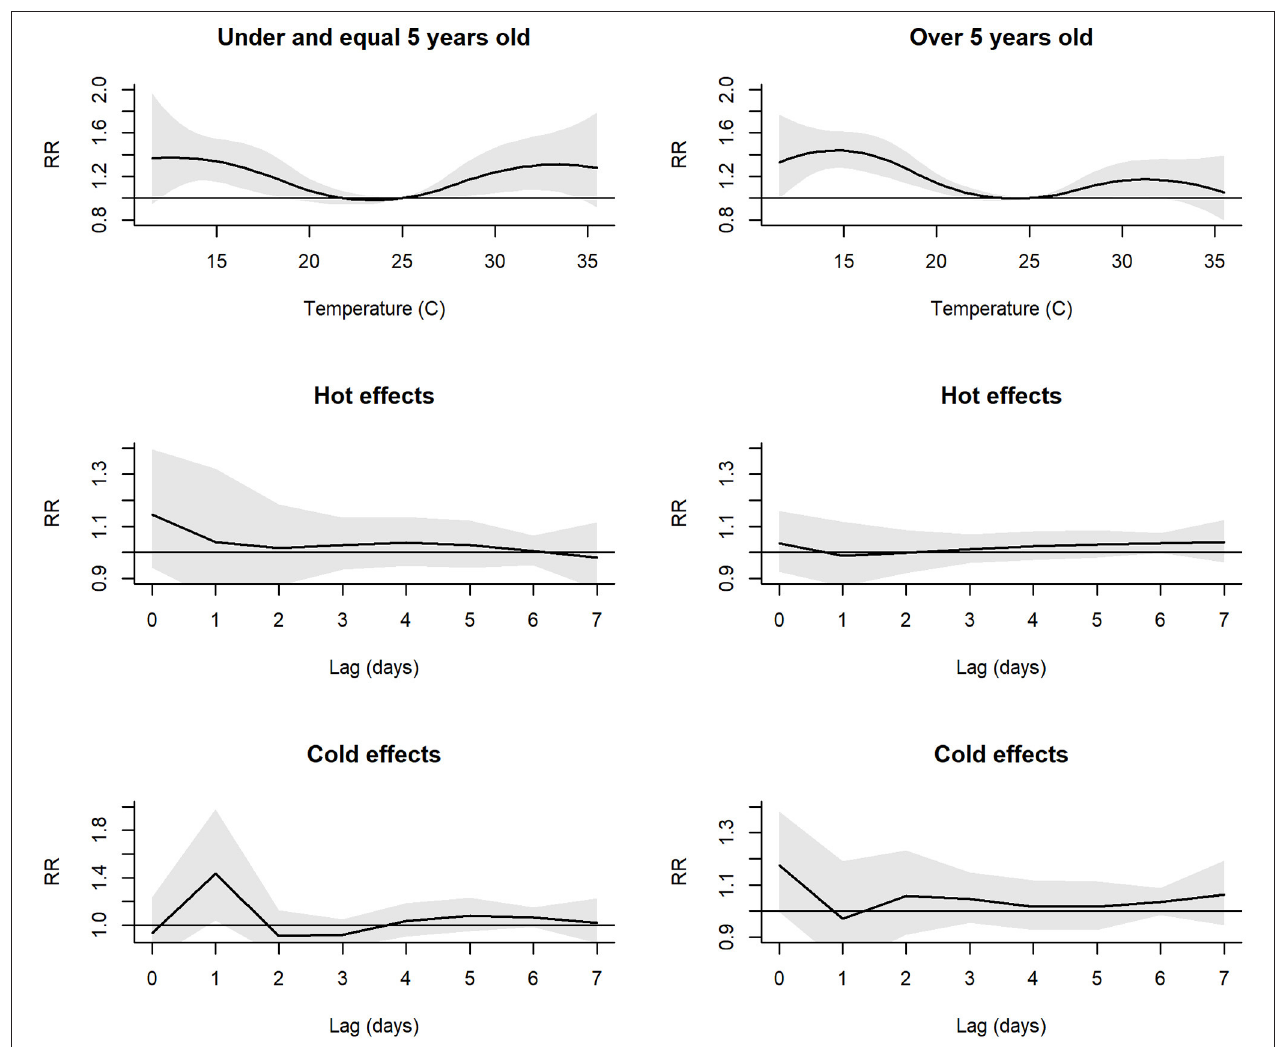
FIGURE 3 | Plot of RR between daily mean temperature and hospital admissions and individual lag-response curves for hot and cold effects, stratified by age groups. Shaded areas denote 95% CI.